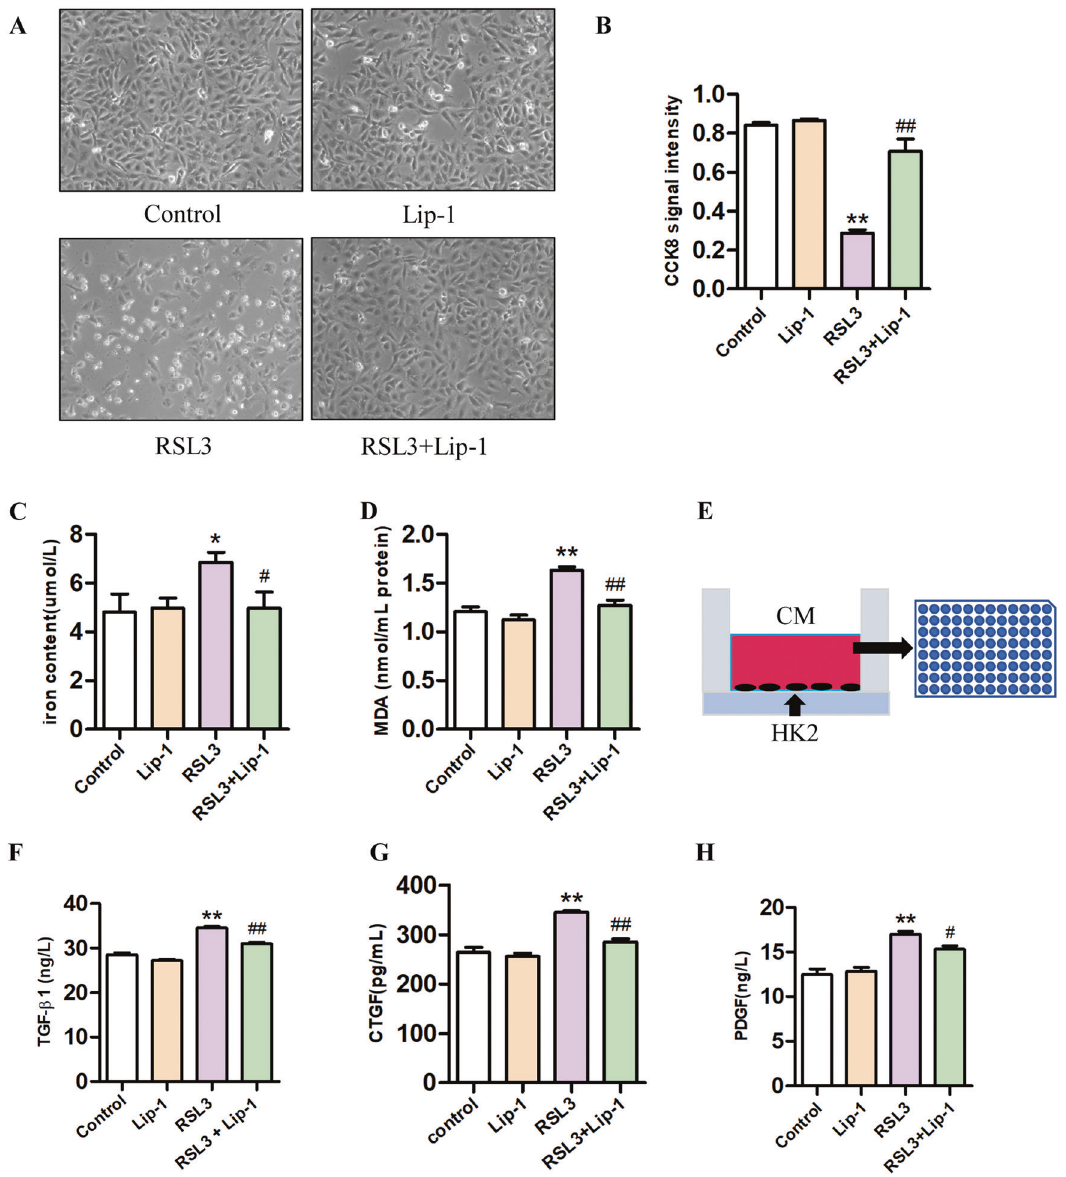
Fig. 5 Effects of Liproxstatin-1 on RSL3-induced HK2 cells ferroptosis and pro fi brotic factor secretion. A The morphological of HK2 cells by a light microscope after the treatment for 24 h. B Viability of HK2 cells, evaluated by the CCK-8 assay ( n = 3, ** P < 0.01 vs control group; ## P < 0.01 vs RSL3 group). C Iron concentrations in HK2 cells ( n = 6, * P < 0.05 vs control group; # P < 0.05 vs RSL3 group). D MDA levels in the HK2 cells ( n = 6, ** P < 0.01 vs control group; ## P < 0.01 vs RSL3 group). E Experimental design. F – H TGF- β 1, CTGF, and PDGF levels in the HK2 cells conditioned medium ( n = 3, ** P < 0.01 vs control group; # P < 0.05, ## P < 0.01 vs RSL3 group). The data are presented as the mean ±